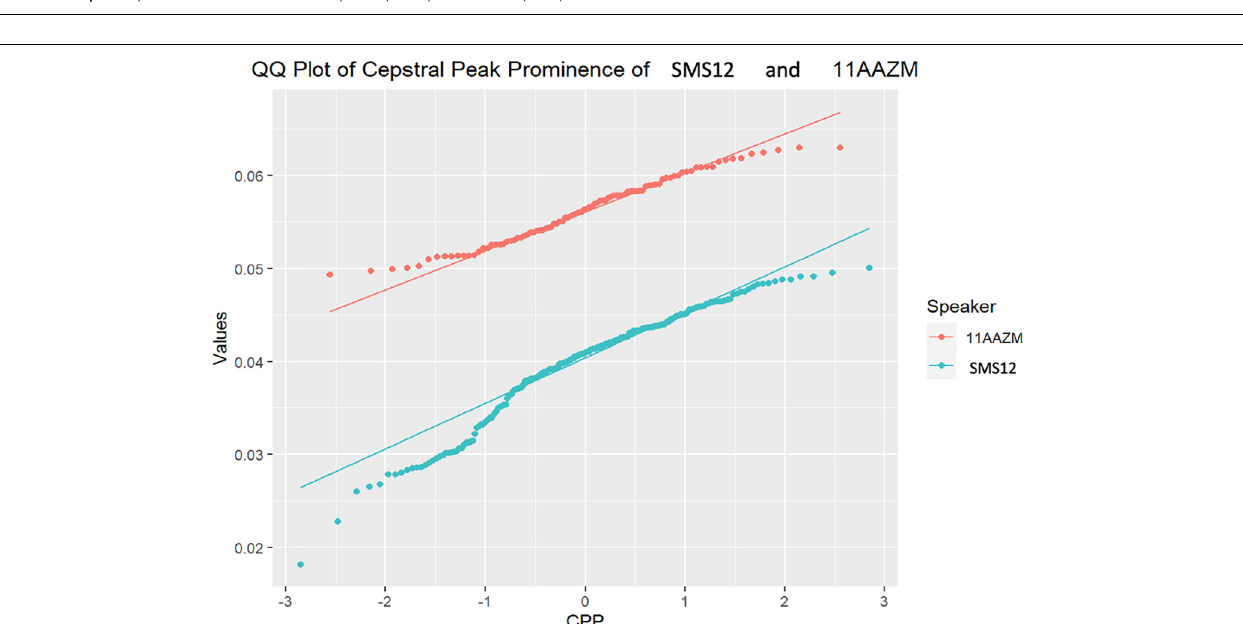
FIGURE 6 | Q–Q plot of SMS3 and 618O cepstral peak prominence (CPP) distributions.